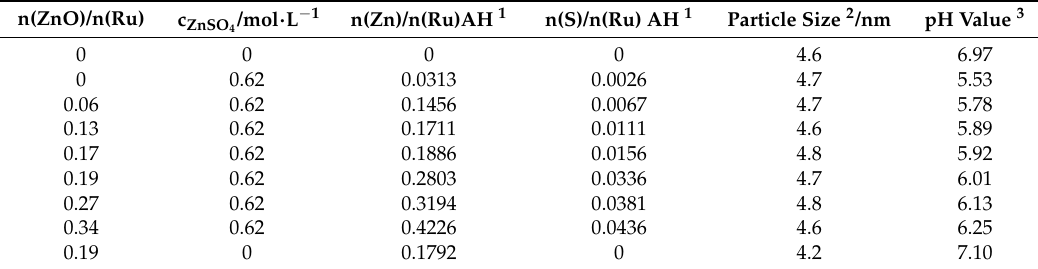
Table 1. Concentration of ZnSO 4 (c ZnSO4 ), molar ratio of Zn to Ru as well as S to Ru, particle size of the Ru-4.7 catalyst and pH values of the slurry after catalytic experiments with different molar ratio of ZnO to Ru. n(ZnO)/n(Ru)